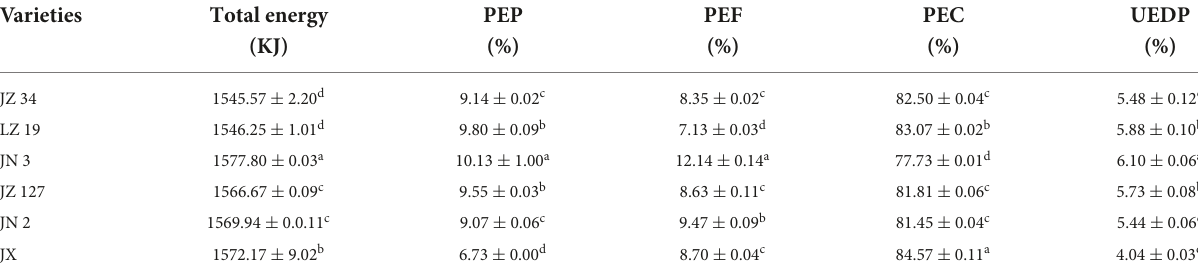
Data are represented as the mean ± SD of triplicate determinations. For each column, values not displaying the same letter are significantly different ( p < 0.05). JZ 34, jinza 34; LZ 19, liaoza 19; JN 3, jinnuo 3; JZ 127, jiza 127; JN 2, jiniang 2; JX, jiaxian. PEP, proportion of total energy due to protein; PEF, proportion of total energy due to fat; PEC, proportion of